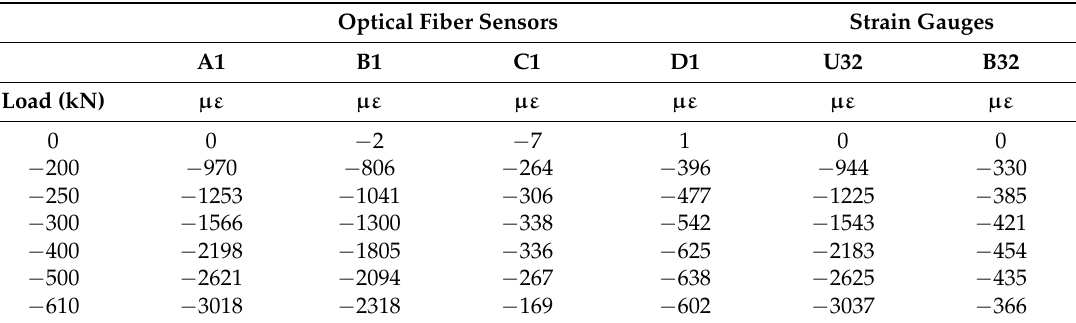
Table 4. Failure Load Test Data.